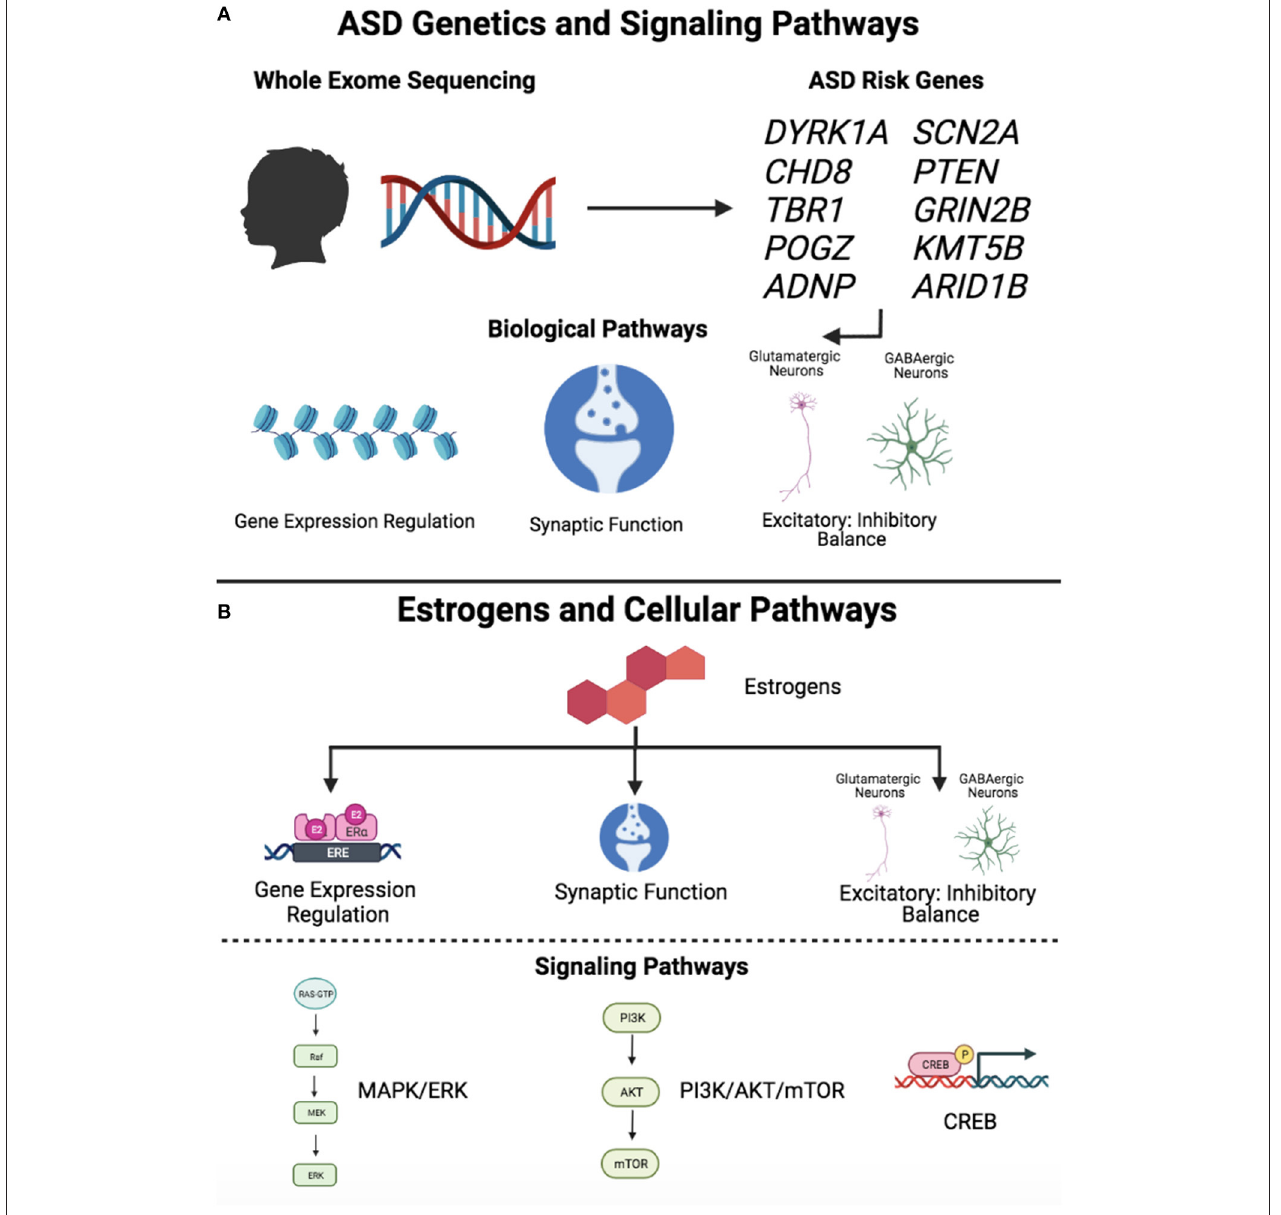
FIGURE 3 | Signaling pathways downstream of ASD risk genes and estrogens. (A) ASD genetics and signaling pathways. Whole exome sequencing studies have led to the identification of high confidence ASD risk genes, which converge on common biological pathways, including gene expression regulation, synaptic function, and excitatory-inhibitory balance. (B) Estrogens and cellular pathways. Estrogens have been shown to affect several biological pathways, including gene expression regulation, synaptic function, and excitatory-inhibitory balance. Estrogens exert effects through intracellular signaling pathways, including MAPK/ERK, PI3K/Akt/mTOR, and CREB. Figure created with BioRender.com. “Gene Expression Regulation” and “PI3K/AKT/mTOR” symbols (Estrogens and Cellular Pathways, lower panel) adapted from “Estrogen Receptor Signaling” and “KRAS Signaling Pathways,” respectively, by BioRender.com (2021). Retrieved from https://app.